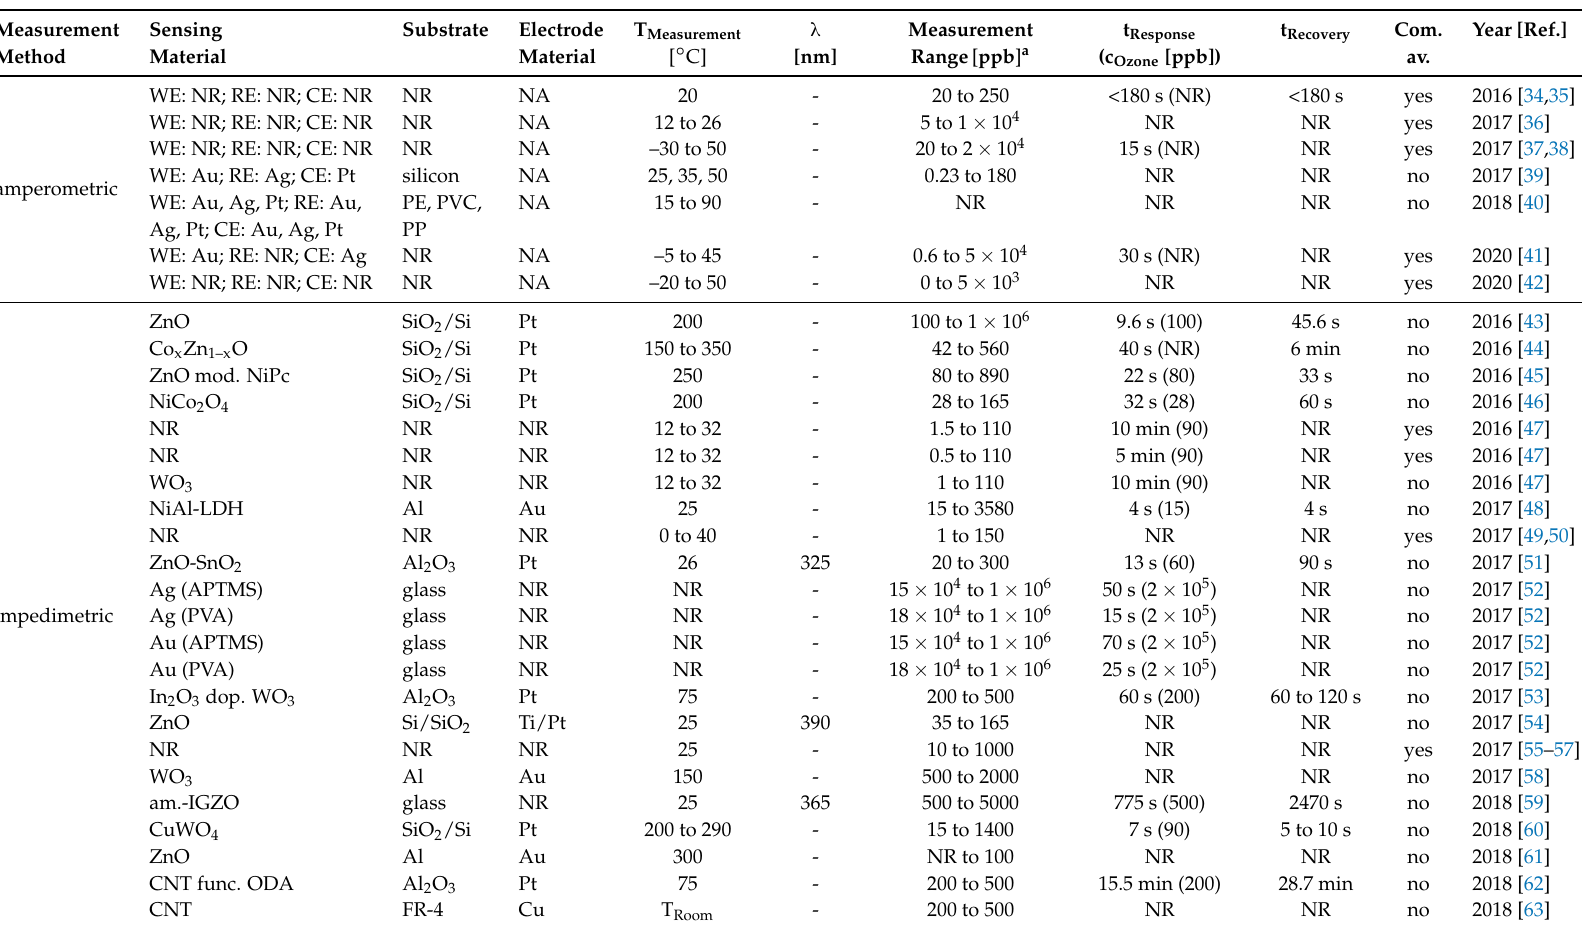
Table 3. A summary of important publications in the period between 2016 and 2020 focused on amperometric, impedimetric, optical absorption, and photoluminescence ozone gas sensors. Information about highly significant criteria—such as sensing material, measurement temperature, and response time—is provided. For impedimetric sensors, an entry of the wavelength shows that light activation of the sensor surface is present, which enhances the sensor response at low temperatures. In cases of optical absorption and photoluminescence sensors, the wavelength is necessary for the optical